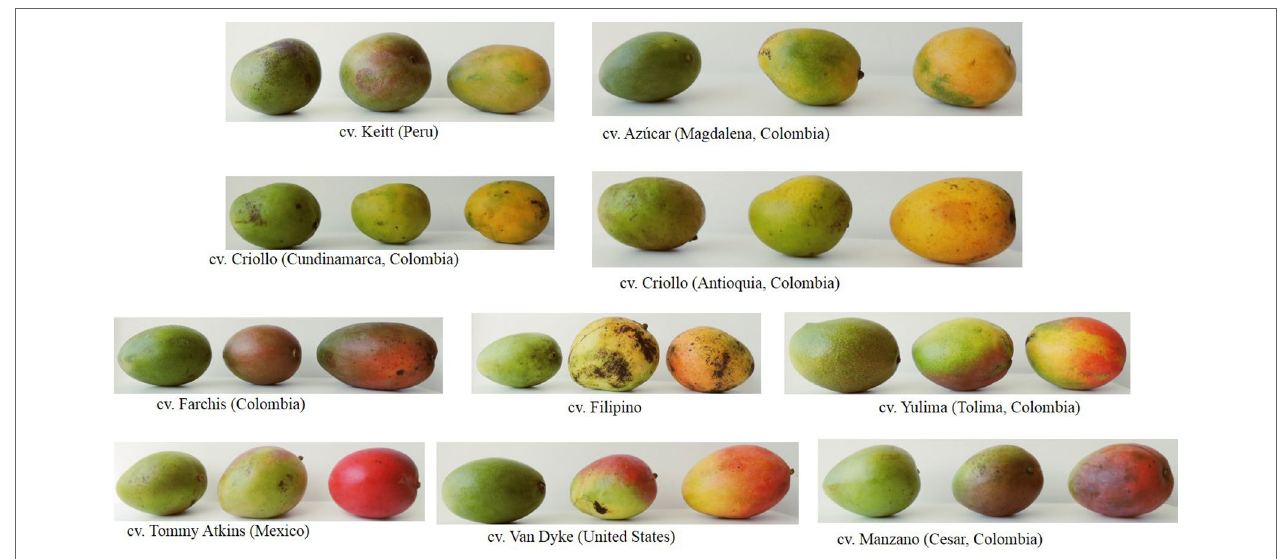
FIGURE 1 | Photographs of mango cultivars in different ripening